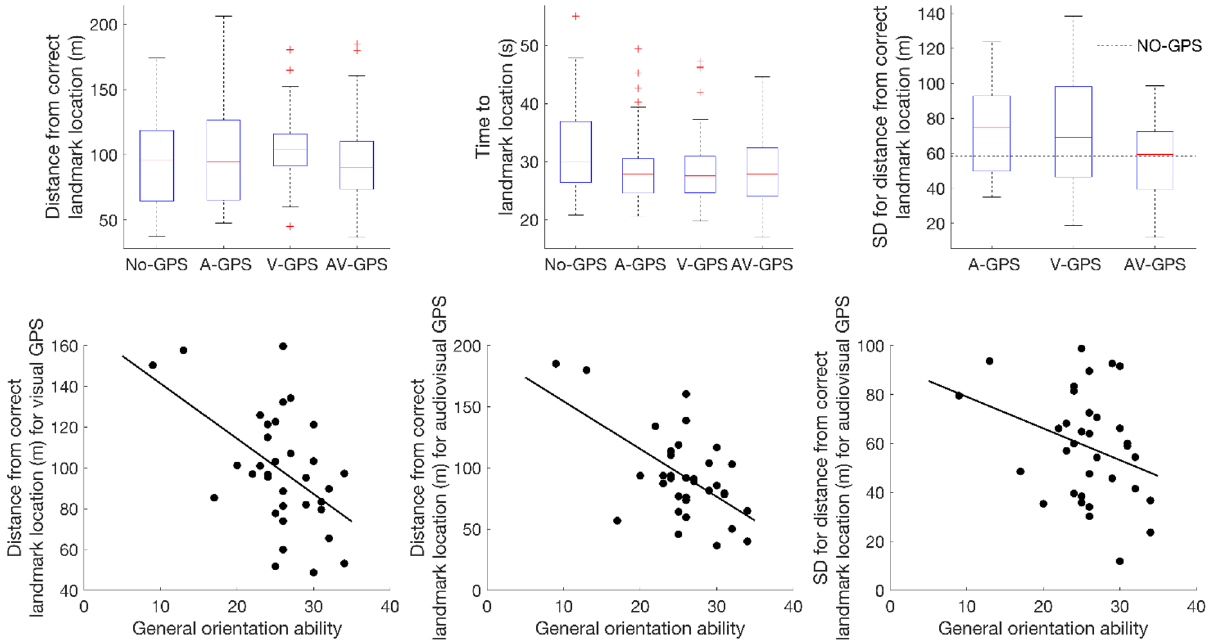
Figure 3. Results of the performances and general orientation ability in the different conditions. The left top panel shows a boxplot for end distance error for the different GPS conditions. The central top panel shows a boxplot for the time participant took to arrive to the target landmark for the different GPS conditions. The right top panel shows a boxplot for the standard deviation for the end distance error in the different GPS conditions. The bottom left panel shows the relation between individual “general orientation ability” and “end distance” error in the visual GPS condition, the bottom middle panel shows the relation between individual “general orientation ability” and “end distance” error in the audio–visual GPS condition, and the bottom right panel shows the relation between individual “general orientation ability” and “variability” in end distance error (or standard deviation) in the audio–visual GPS condition. The red line in the boxplot represents the median and the box the interquartile range (IQR). Note: Friedman’s and Wilcoxon’s tests are carried out by comparing mean ranks between conditions, but we reported medians and IQRs as descriptive measures as they are more commonly reported for non-parametric tests. See supplemental material for measures of mean